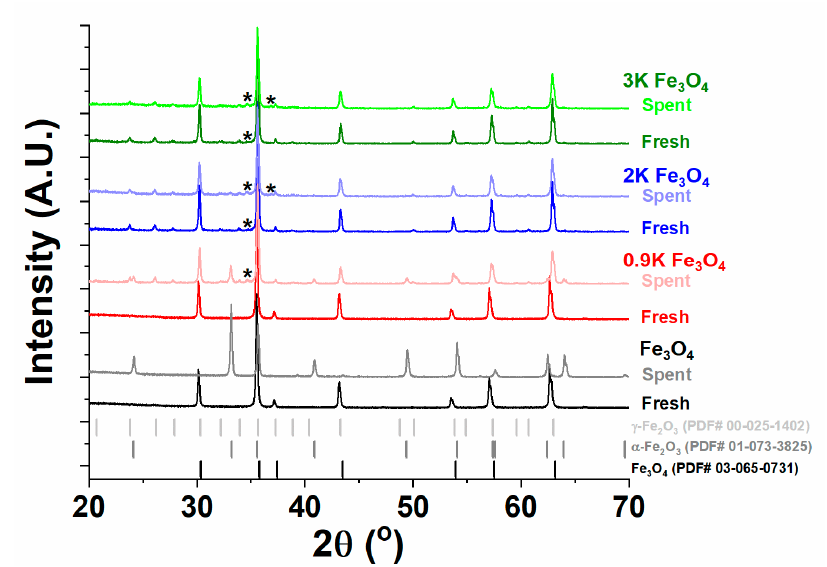
Figure 8. X-ray diffraction patterns of fresh and spent Fe 3 O 4 catalysts with varying K loadings. Short vertical lines indicate the position of reflections of Fe 3 O 4 (PDF# 04-015-3101), α -Fe 2 O 3 (PDF# 01-073-3825), and γ -Fe 2 O 3 (PDF# 00-025-1402) for reference. Asterisks indicate reflections related to the presence of an additional iron-potassium oxide phase in all spent K-containing samples and in fresh 2K and 3K samples.